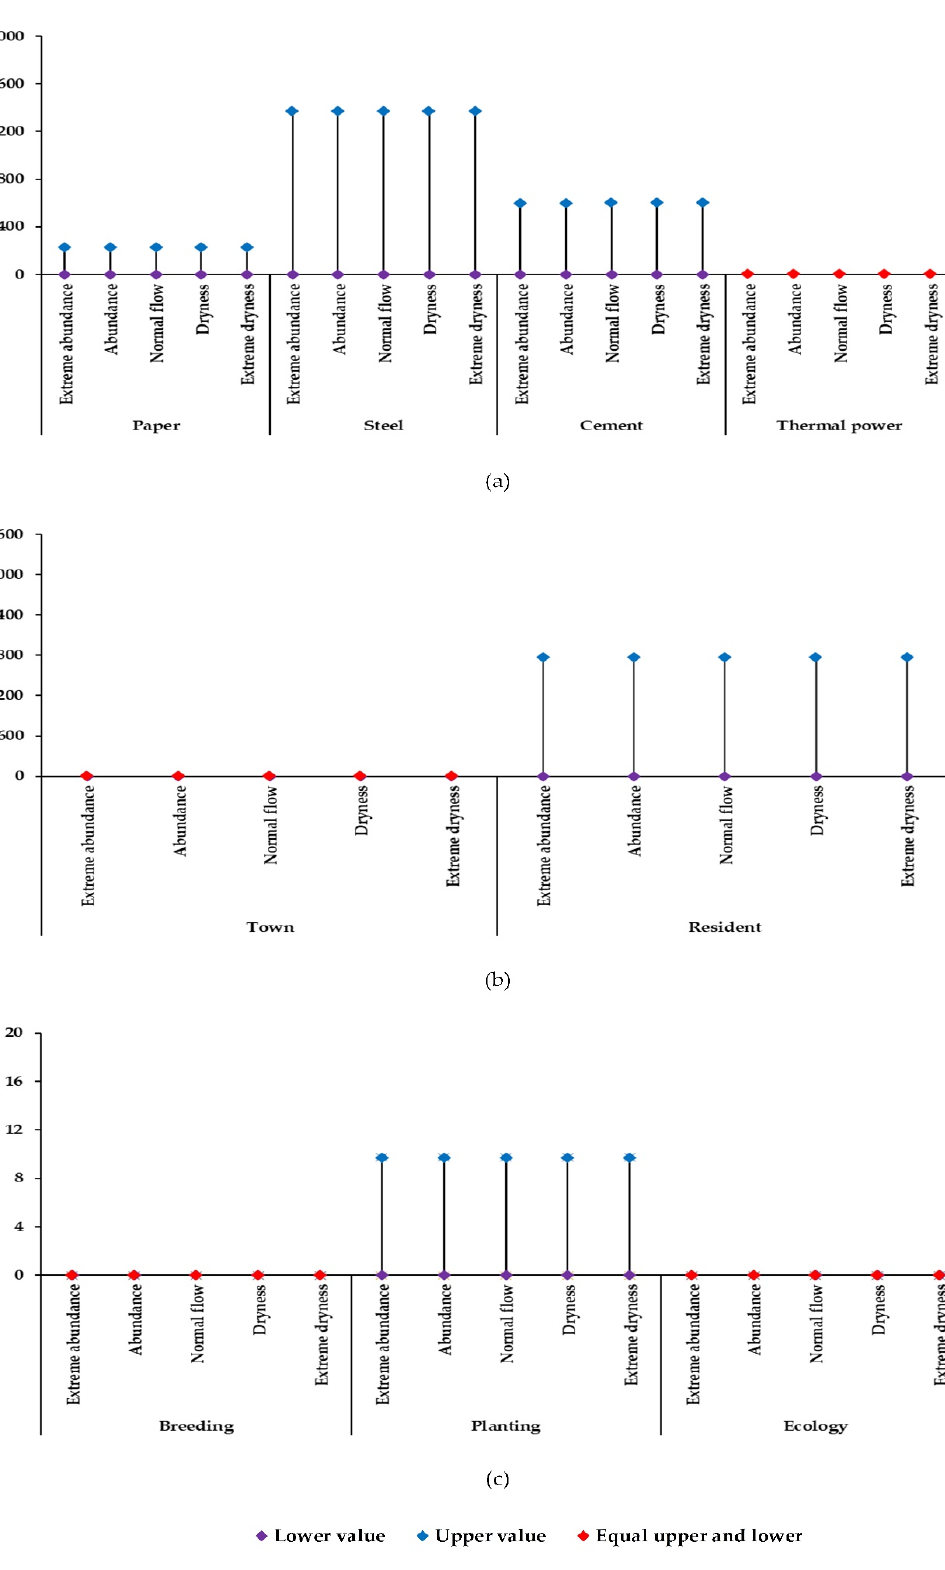
Figure 3. Different hydrological situations in different departments in the second stage of Shanghang water increment (×10 4 t): ( a ) Industrial sectors; ( b ) Municipal sectors; ( c ) Agriculture and Ecology.